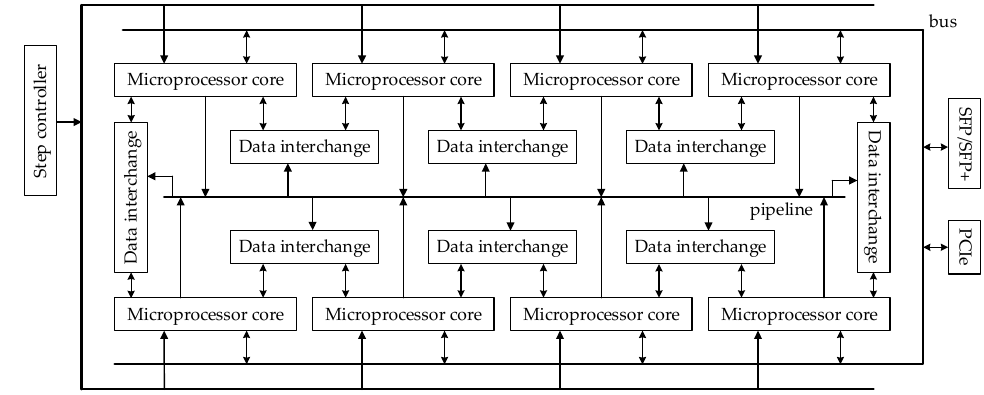
Figure 11. Multi-solver real-time simulation platform—FPGA-based real-time digital simulation